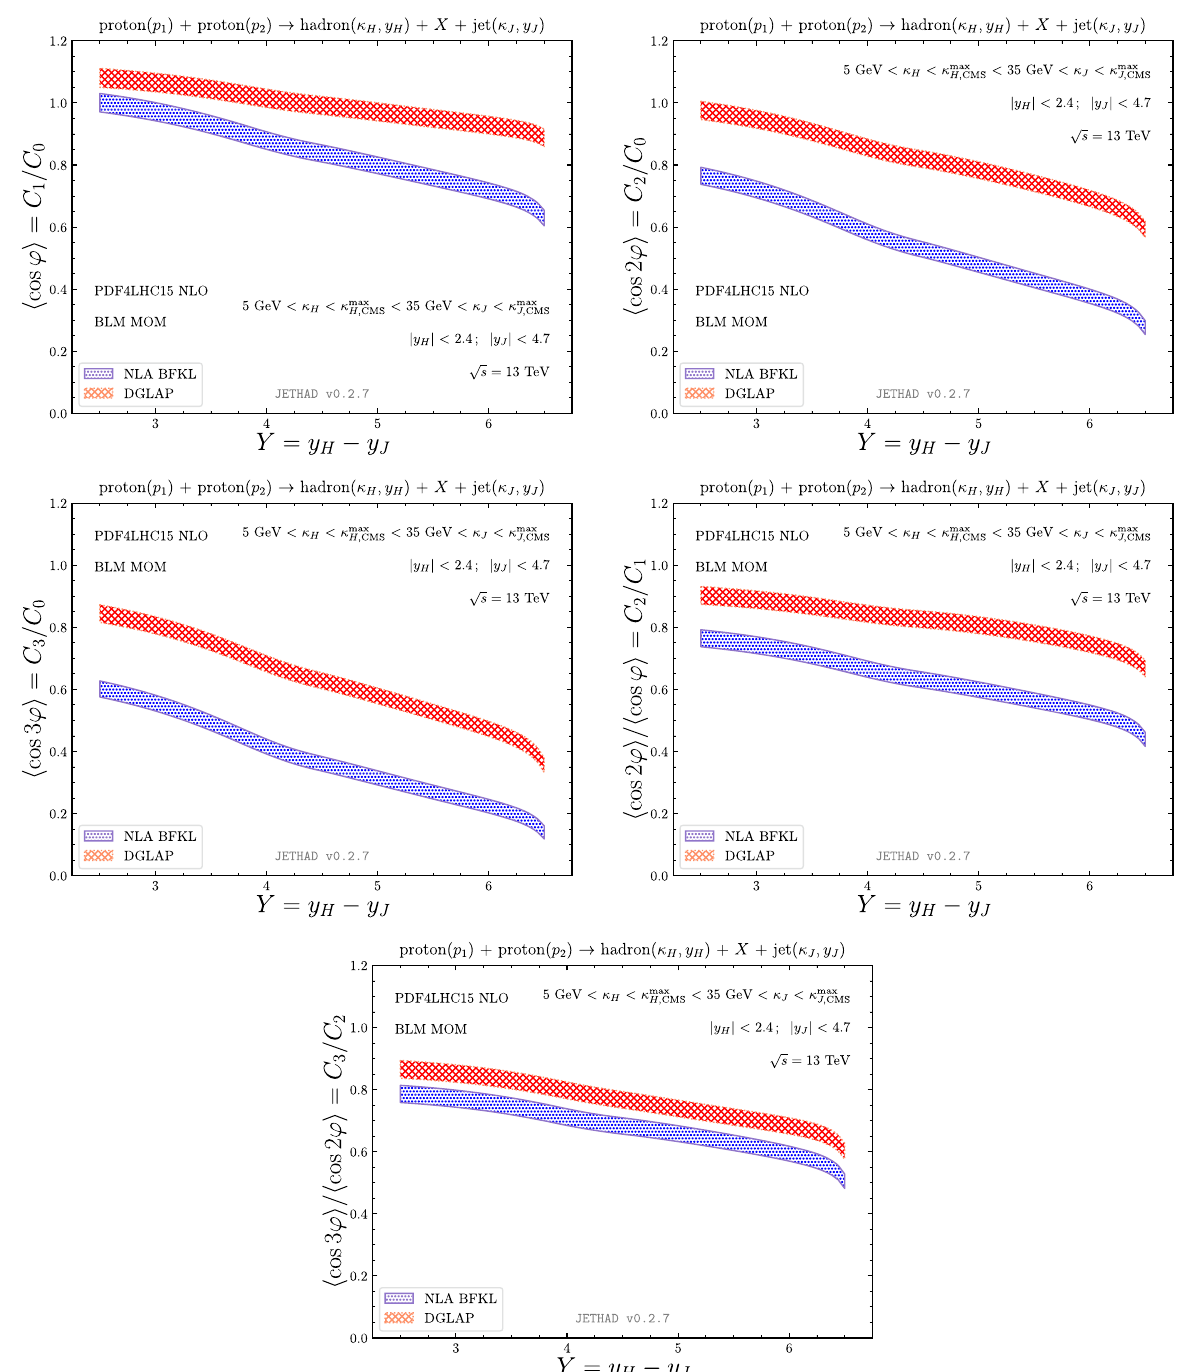
Fig. 13 Y -dependence of several azimuthal correlations, R nm ≡ C n / C m , of the inclusive hadron-jet production (central panel of Fig. 2) √ s = 13 TeV ( asymmetric CMS config- for μ F 1 , 2 = μ R = μ BLM and R